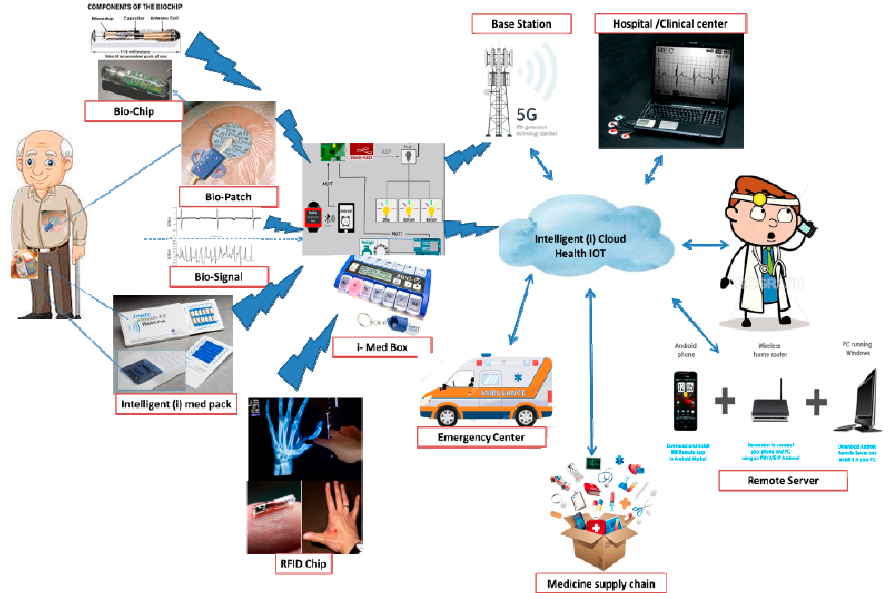
Figure 4. Application scenario for the proposed iHome Health-IoT system.